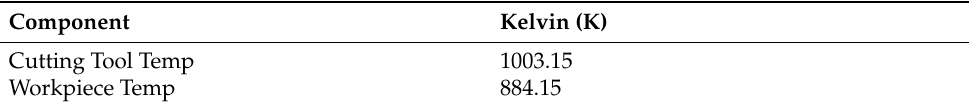
Table 6. Maximum temperature attained by the cutting tool and